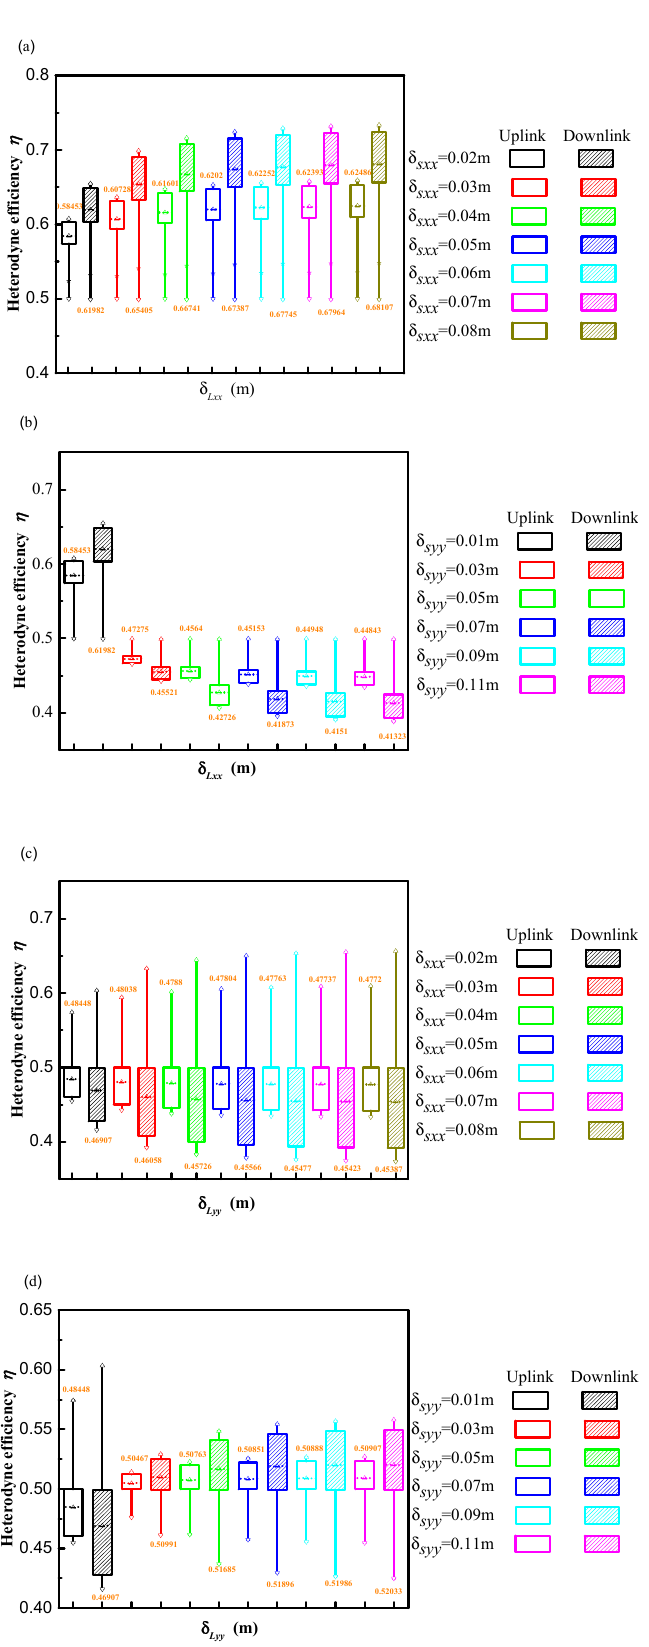
Figure 5. Effect of coherence length of LO beam on the heterodyne efficiency on an uplink path and a downlink path. ( a ) δ Lxx and δ Sxx , ( b ) δ Lyy and δ Syy , ( c ) δ Lxy and δ Sxy , ( d ) δ Lyx and δ Syx The heterodyne efficiency and DoP are displayed as functions of the inner scale and outer scale, respectively, in Figure 6a,b. The heterodyne efficiency and DoP are enhanced with the increasing inner scale l 0 and decrease with the raising outer scale L 0 , as shown in Figure 6a,b. The heterodyne efficiency and DoP on the downlink path are also higher than that on the uplink path. The DoP and heterodyne efficiency are significantly affected by the inner scale carried on by atmospheric turbulence, as seen in Figure 6a,b.